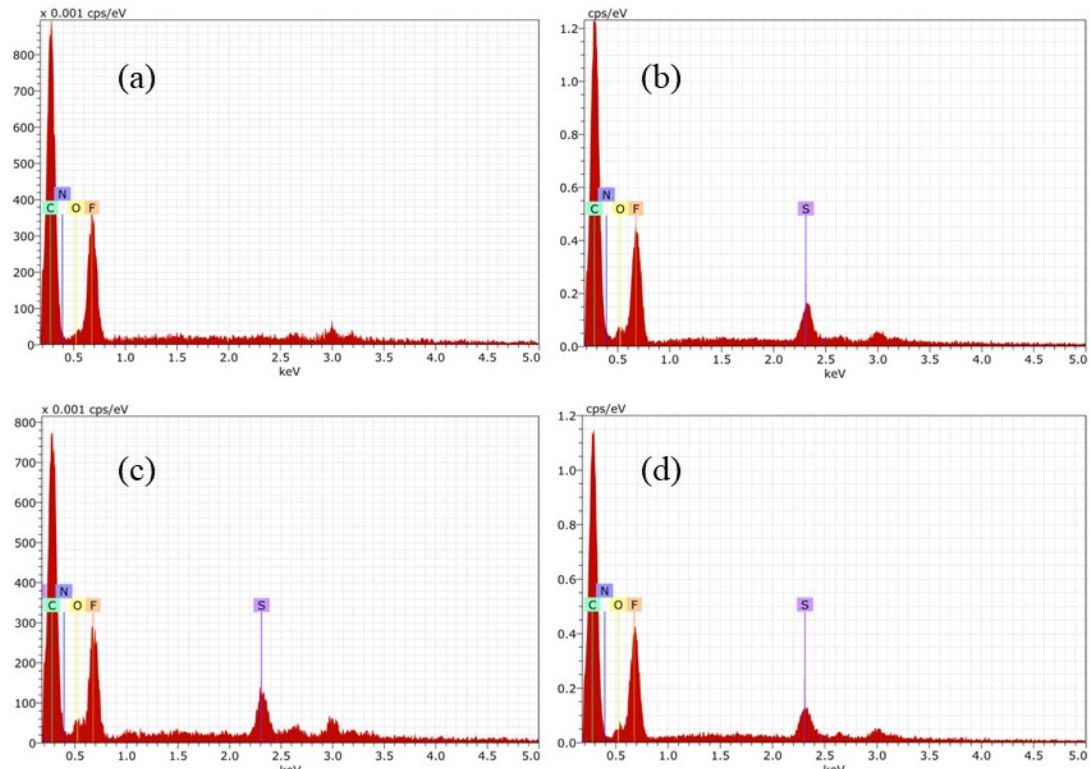
Figure 6. EDS for membranes containing PEI: ( a ) M1, ( b ) M2, ( c ) M3 y ( d ) M4.